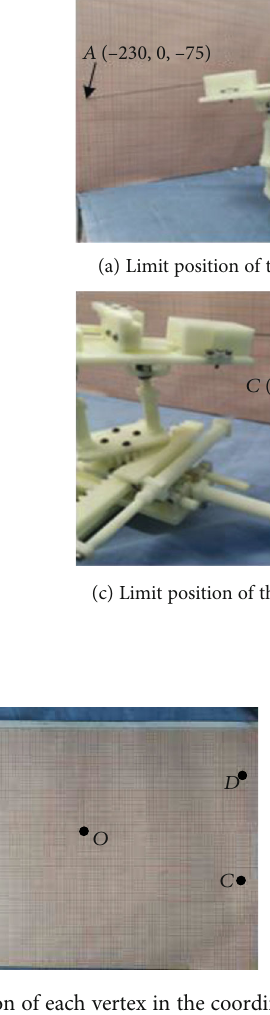
Figure 23: XOY plane set zero coordinate.